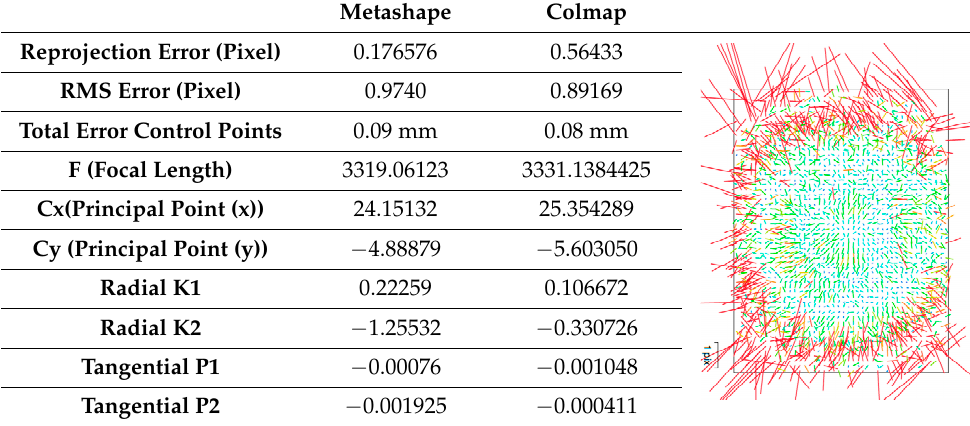
Table 8. iPhone X camera calibration results using Metashape calibration procedure and self-cali- bration in COLMAP: number of images used = 20; camera stations = 20; ground resolution = 0.090 mm/pix. On the right: image residuals in Agisoft Metashape.